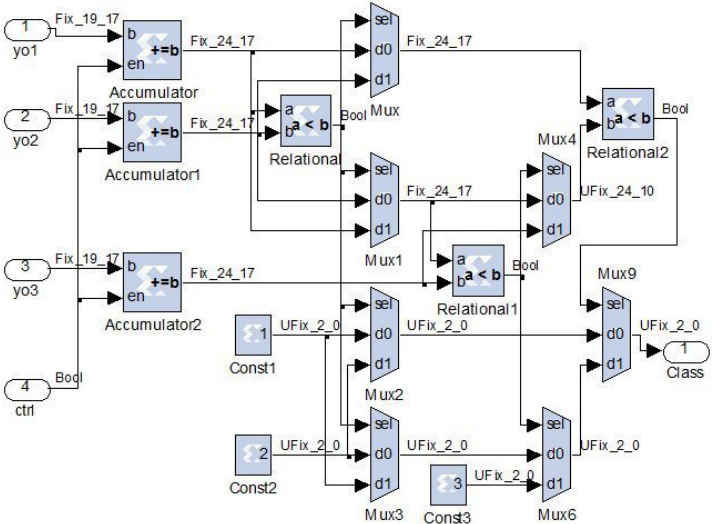
Figure 8. Implementation of the class